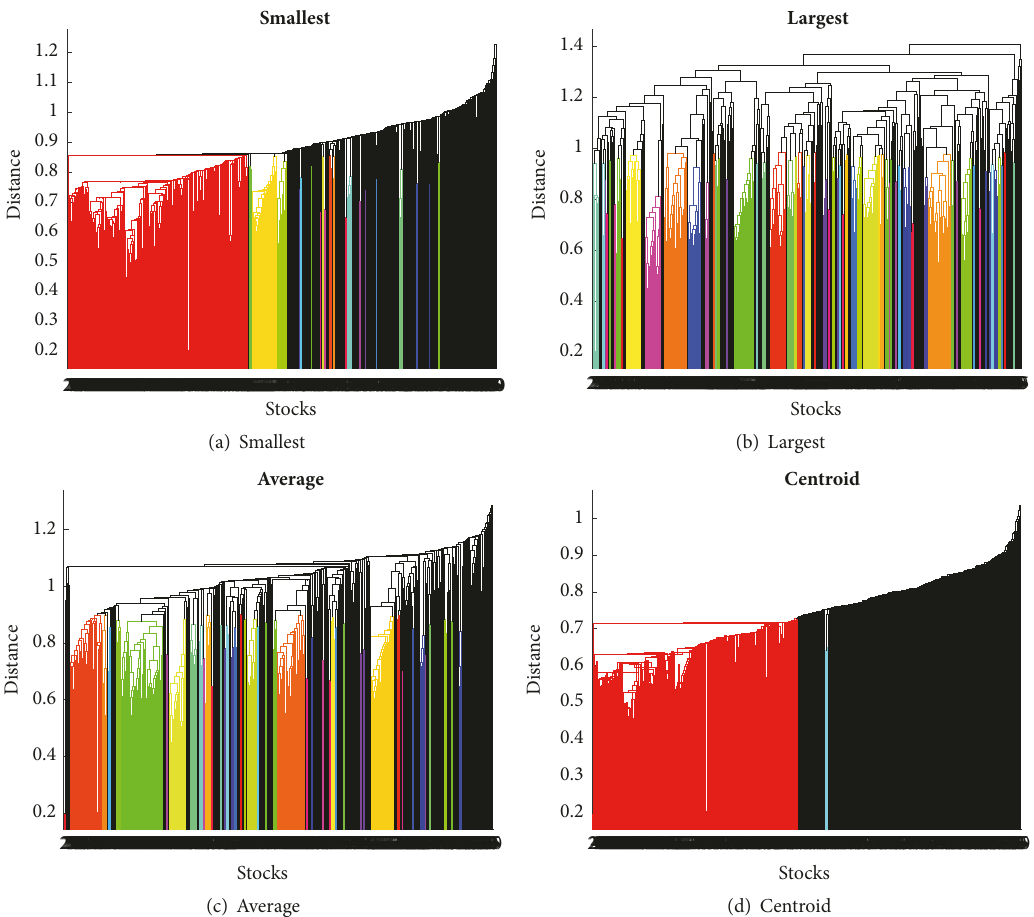
Figure 11: S&P468 dendrogram hierarchical cluster trees extracted with different distance definitions in (a) smallest distance for stock pairs, equation(8);(b) largest distancefor stockpairs, equation (9); (c)averagedistancefor stockpairs, equation (10); (d) distancebetween centroids for clusters,equation (11). Thecolorthreshold is 0.7. All stockswhoselinkage valuesareless than this threshold would becolored with aunique color. As shown in the figures, different distance definitions extract different dendrogram hierarchical cluster trees whereas the same color threshold generates different results. Again, the largest distance definition reveals more details of network.